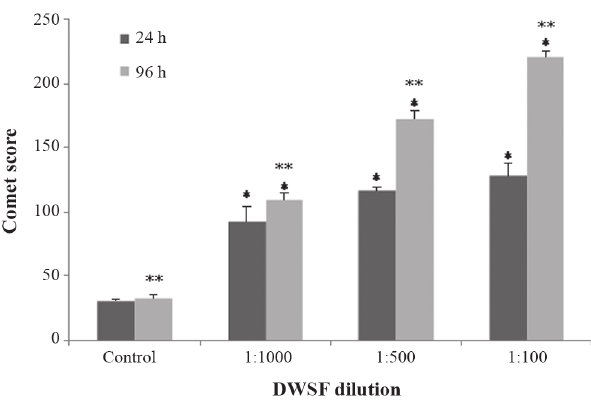
Fig. 1. Comet score (CS) in Procholidus vimboides exposed to different water soluble fractions of diesel (1:1,000, 1:500 and 1:100) for 24 and 96 h. The results are expressed as the mean ± standard deviation. *: Significant difference between one dilution and the respective control after 24- or 96-h exposure periods using an ANOVA and the Dunn’s test (p<0.05). ** Significant difference between the two exposure times (24 and 96 h) for the same dilution using the T- test